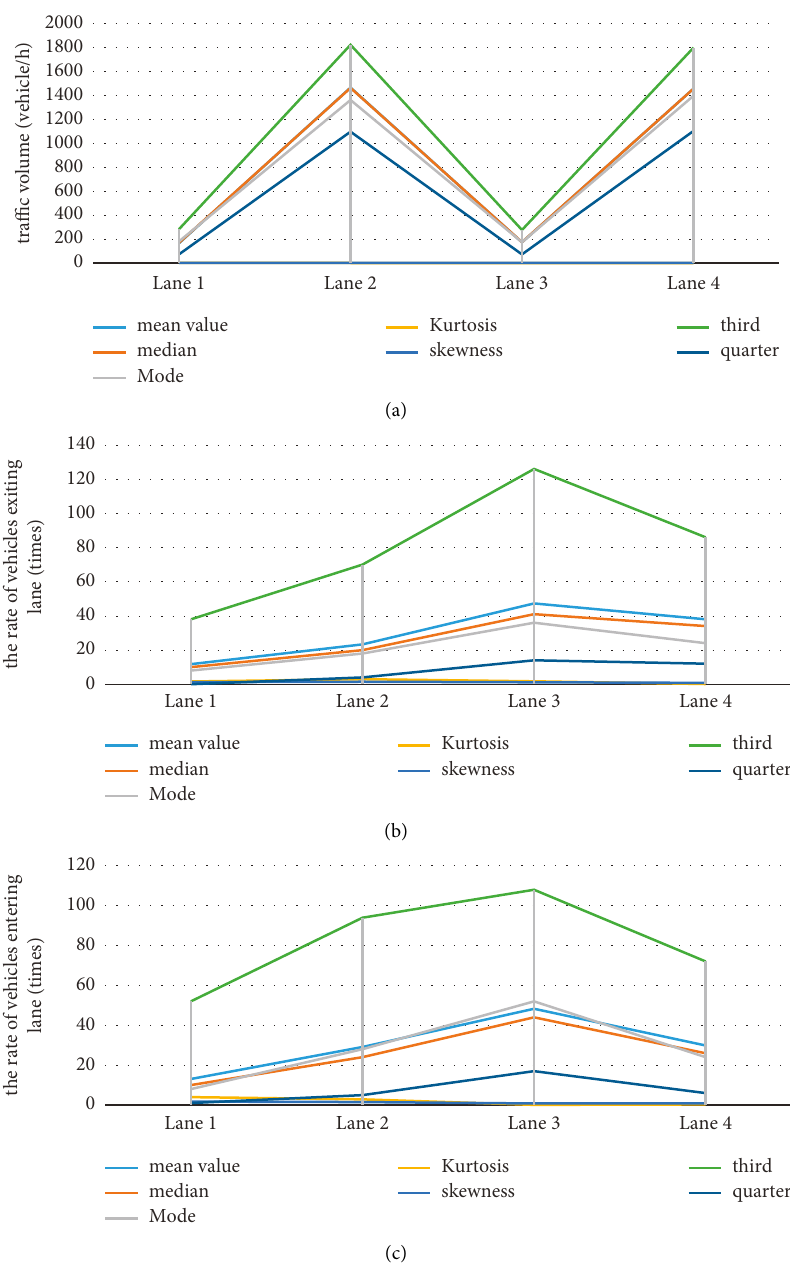
Figure 5: Feature distribution diagram of simulated traffic. (a) Distribution map of traffic volume by each lane. (b) Feature distribution map of the rate of vehicles exiting lane by each lane. (c) Feature distribution map of the rate of vehicles entering lane by each